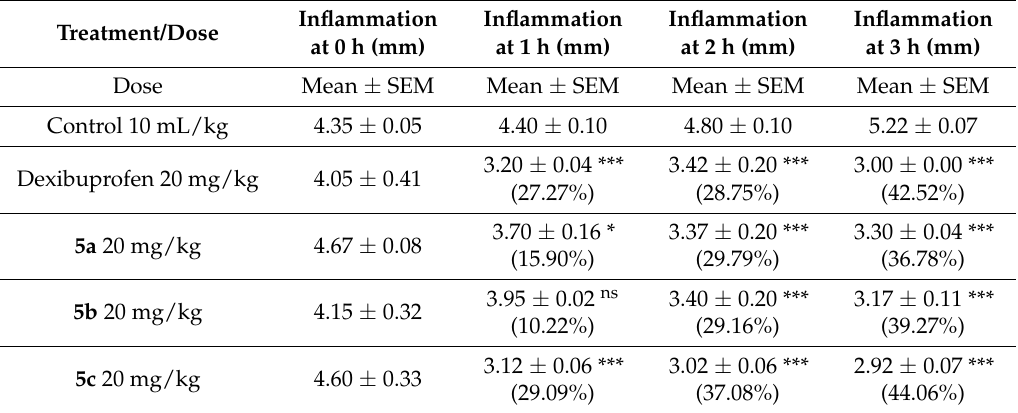
Table 2. Effect of mutual prodrugs ( 5a – c ) in egg albumin induced paw edema (mm) in mice. Treatment/Dose